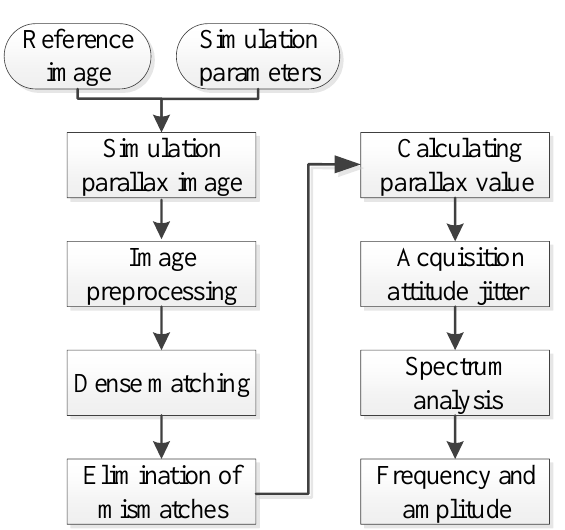
Figure 1. Overall workflow of the proposed